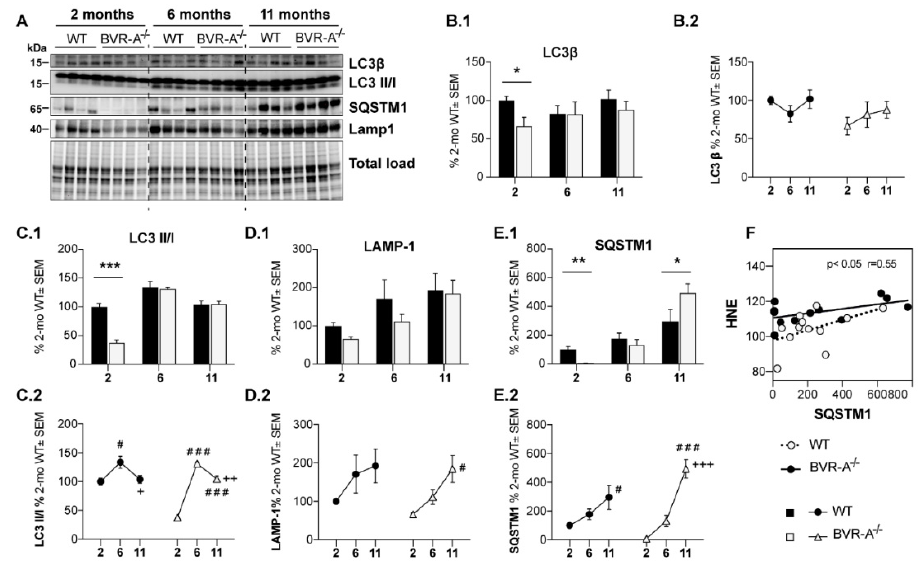
Figure 4. Reduced autophagosome maturation occurs in the cerebral cortex of BVR-A − / − mice. Representative western blot images ( A ) and densitometric evaluation of LC3 β ( B.1 , B.2 ), LC3 II / I ratio ( C.1 , C.2 ), LAMP-1 ( D.1 , D.2 ) and SQSTM1 ( E.1 , E.2 ) levels in the cerebral cortex of WT and BVR-